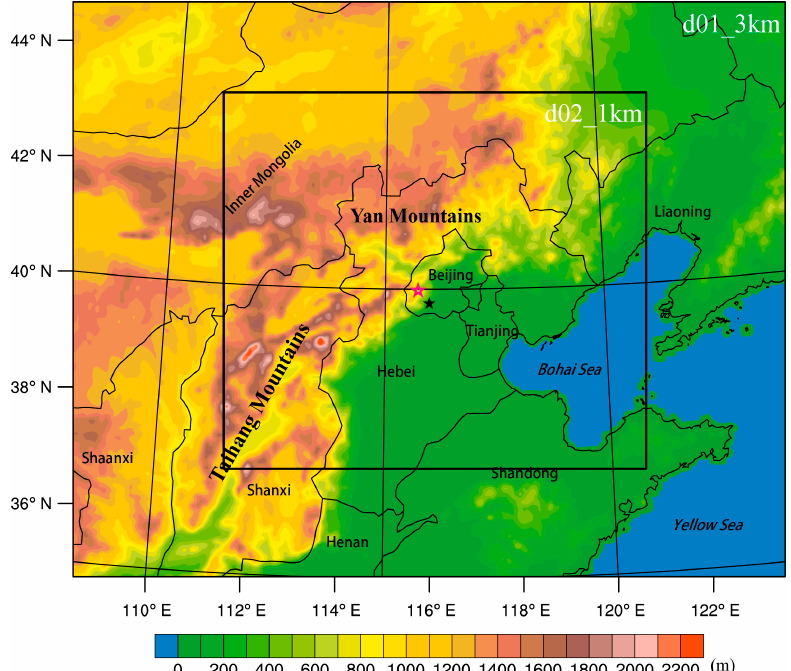
Figure 1. Topography (shaded) diagram in the simulation domains (d01, d02). The Taihang Mountains and Yan Mountains (bold font) and some provinces of China (regular font) over the domains are labeled. Mentougou District and Fangshan District of Beijing are marked separately by magenta and black pentagrams denoting its downtown